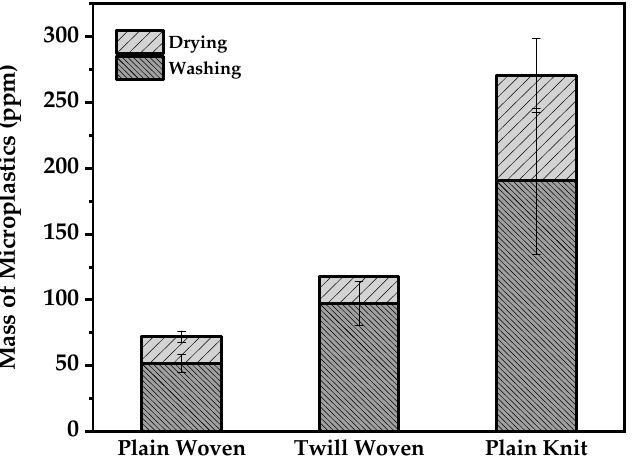
Figure 6. Total mass of microplastics released from washing and drying based on fabric construc- tion.